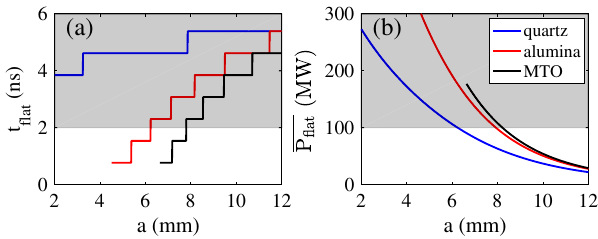
FIG. 4. Duration (a) and average power (b) of the flat-top as a function of the inner radius for different dielectric materials.